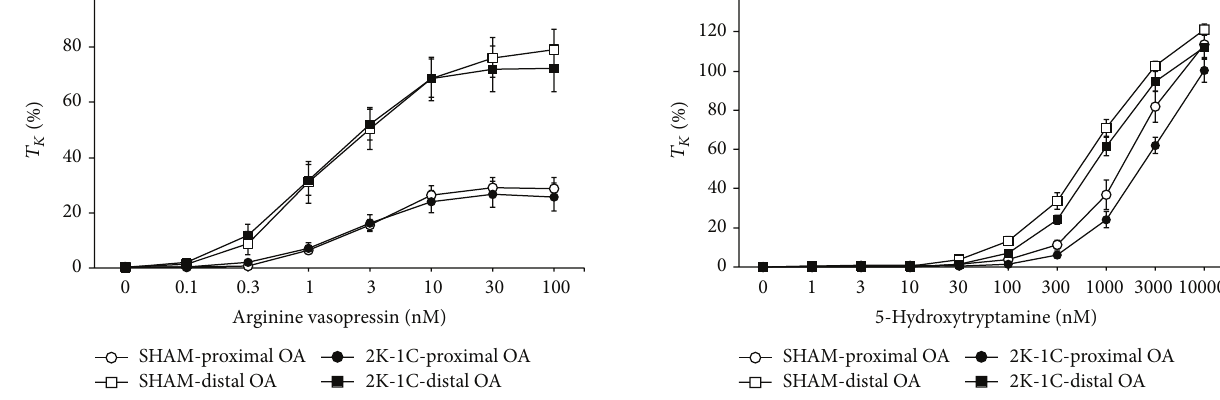
Figure 2: Dose-response effects of arginine vasopressin on tension ofproximalanddistaloccipitalarterysegmentsfromsham-operated (SHAM) and 2-kidney, 1-clip (2K-1C) hypertensive rats. The data are presented as mean ± SEM of the responses expressed as a percentage of that elicited by 80 mM K + (% 𝑇 𝐾 ). There were 8 segments in each group.